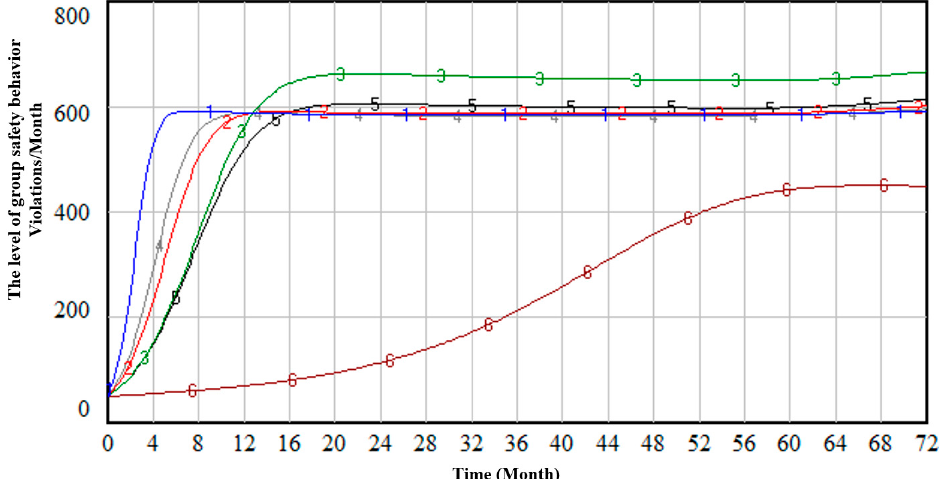
Figure 8. Simulation of safety culture intervention decision. Line 1 shows the impact of safety culture system perfection on the level of group safety behavior, Line 2 shows the impact of rational guidance of group subculture on the level of group safety behavior, Line 3 shows the impact of main culture and sub-culture interface integration on the level of group safety behavior, Line 4 shows the impact of safety style construction on the level of group safety behavior, Line 5 shows the impact of employee safety values shaping on the level of group safety behavior, Line 6 shows the initial data. According to the calculation formula of the decision-making correction strength